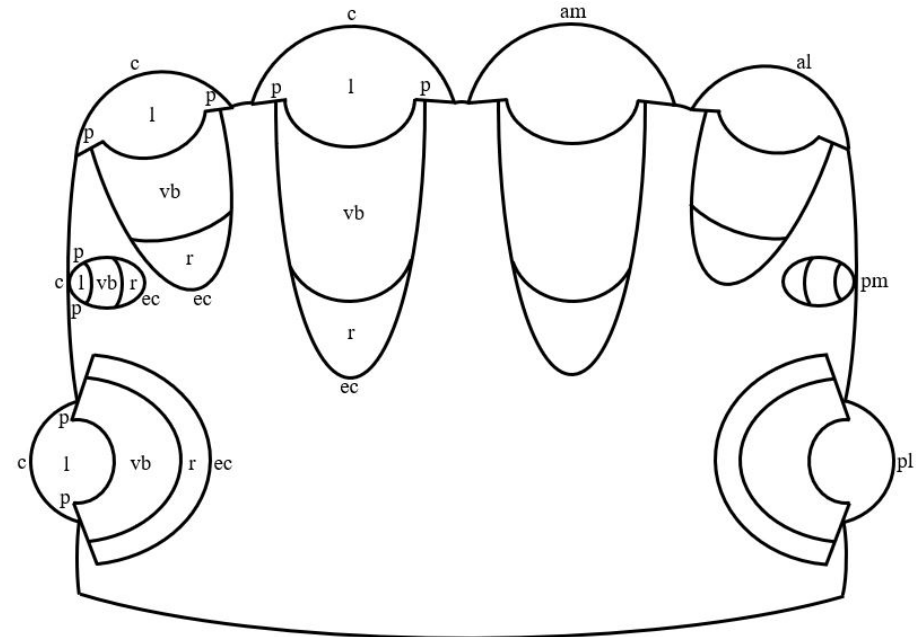
Figure 1. Schematic drawing of the camera-like eyes of jumping spiders. am: antero-median eyes; al: antero-lateral eyes; pm: postero-median eyes; pl: postero-lateral eyes; c: cornea; l: lens; p: pupil; vb: vitreous body; r: retina; ec; eye capsule.